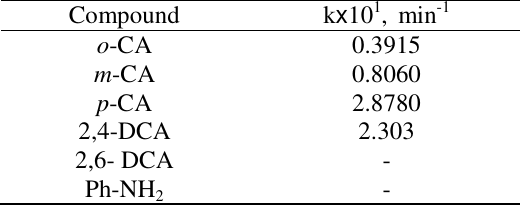
Table 2. Rates of photosensitized dechlorination of